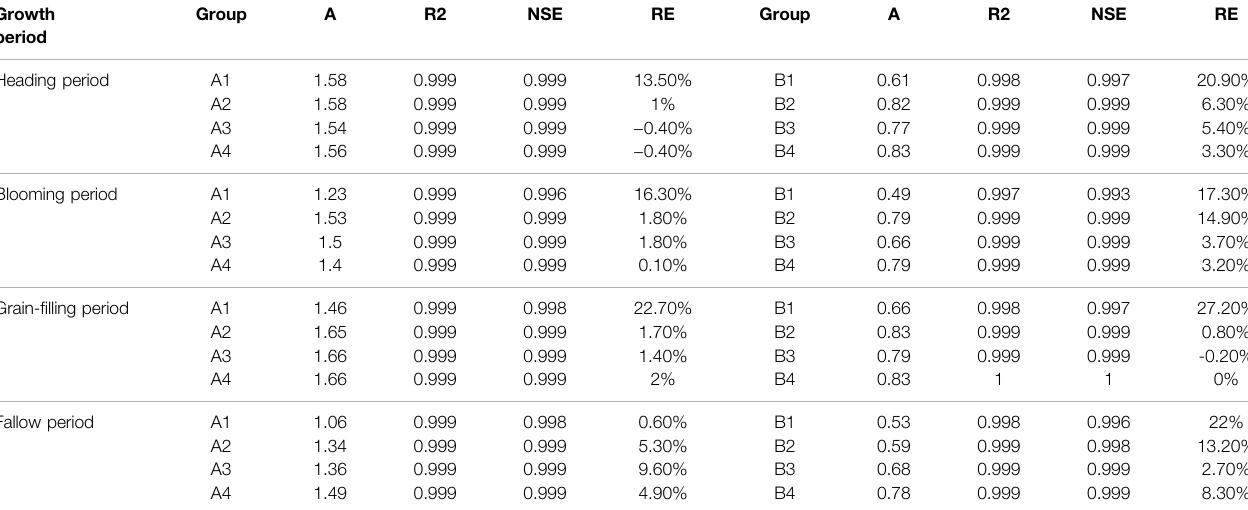
TABLE 2 | The stable in fi ltration rate under different growth periods of different experimental plots and evaluation index of fi tting performance.